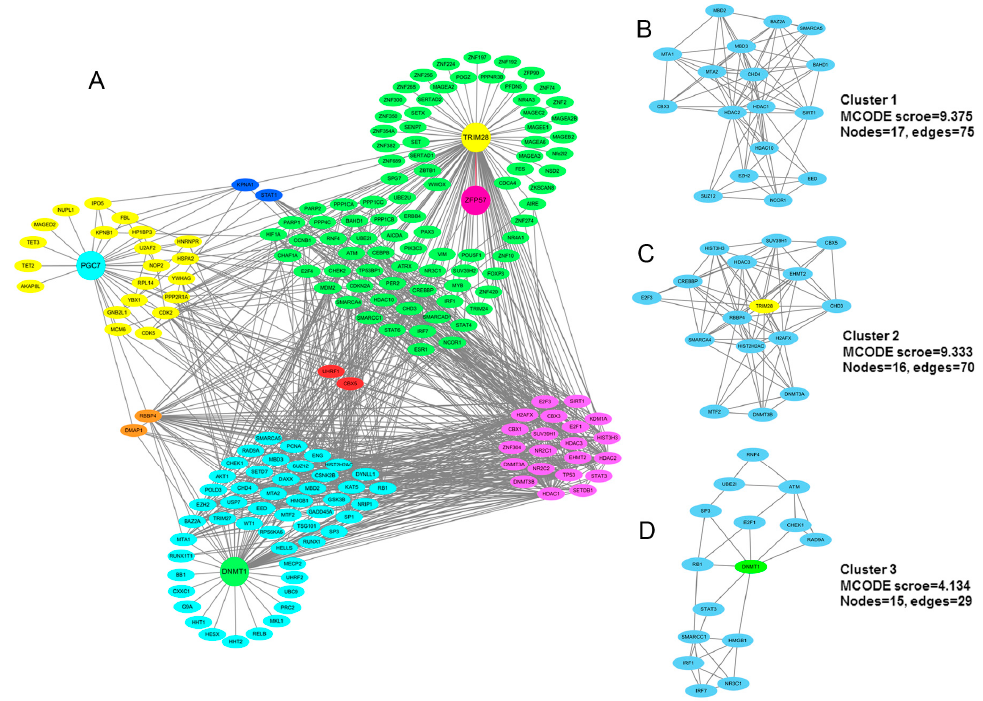
Figure 11. The interaction network of four maternal-effect proteins and their partners. ( A ) In this network, four maternal-effect proteins (PGC7, ZFP57, TRIM28 and DNMT1) and their physical interacting proteins were included. The STRING online tool was used to determine the known interactions between these proteins. A protein–protein interaction (PPI) network containing 189 nodes and 927 edges were constructed, and then further visualized in Cytoscape (version 3.4.0). The two proteins interact with both PGC7 and TRIM28 are coloured in blue ; two proteins interact with both PGC7 and DNMT1 are coloured in orange ; 21 proteins interact with both TRIM28 and DNMT1 are coloured in purple ; and two proteins interact with three of the maternal-effect proteins (PGC7, TRIM28 and DNMT1) are coloured in red . The interacting partners of four maternal-effect proteins are list Supplementary Table S2. ( B – D ) The three tightly connected network clusters obtained with MCODE and rendered as separate modules (MCODE scores ≥ 4 and nodes ≥ 6).